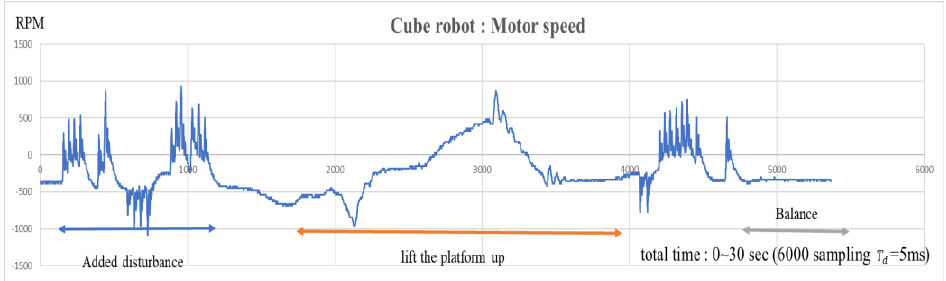
Figure 16. Time response of the tilt angle angular velocity 𝜃̇ 𝑃 of the cube robot balancing on its edge.